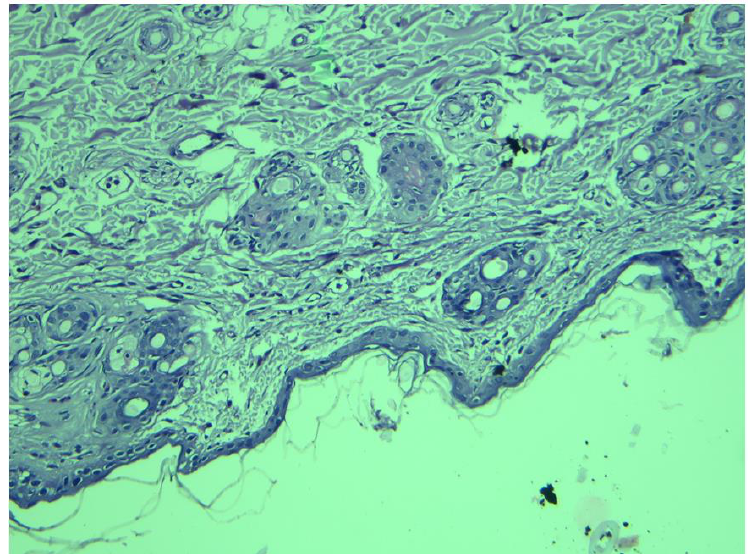
Figure 9. Histopathological examination of shaved rabbit dorsal skin treated with NLC9-loaded HPMC gel for three consecutive days (100×).